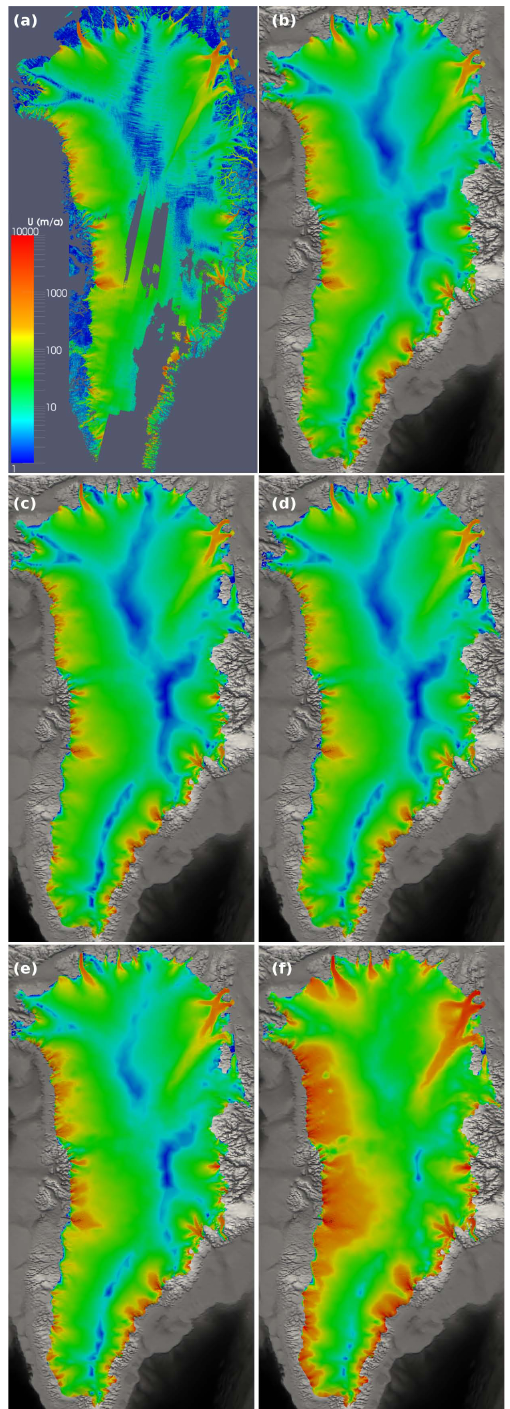
Fig. 1. GrIS surface velocities. (a) Observed surface velocities on the original regular 500m × 500m grid; Computed surface ve- locities: (b) after relaxation; after one century for (c) experiment C1 BF1, (d) experiment C2 BF1, (e) experiment C2 BF2 and (f) experiment C2